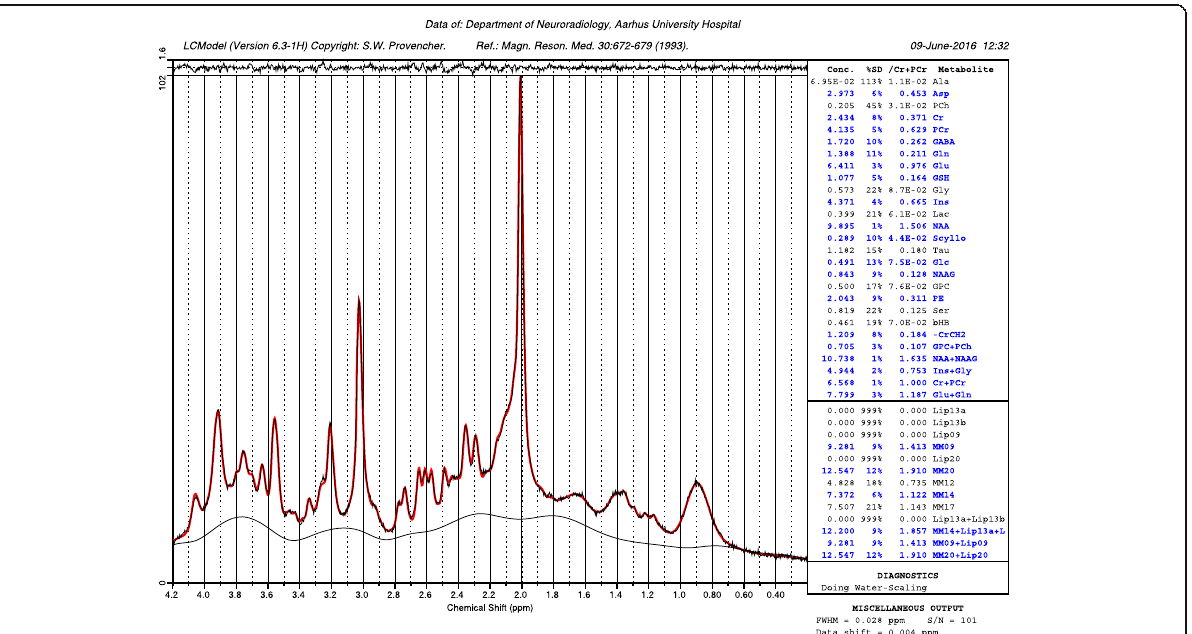
Fig. 2 Top: Example spectrum from a representative migraine patient from the occipital voxel position. The red line is the LCModel fit of the data from this patient, the thin black line with the same shape as the red fit is the raw data. The baseline is the thin black line lowest in the spectrum. At the top of the plot is the residuals of the fitted raw data to the model, i.e. the raw data minus the fitted data. Quality data: for this spectrum: S/N 101 and a delta shift of 0.004 ppm, FWHM = 0.028 ppm. Bottom: The GABA fit from the same